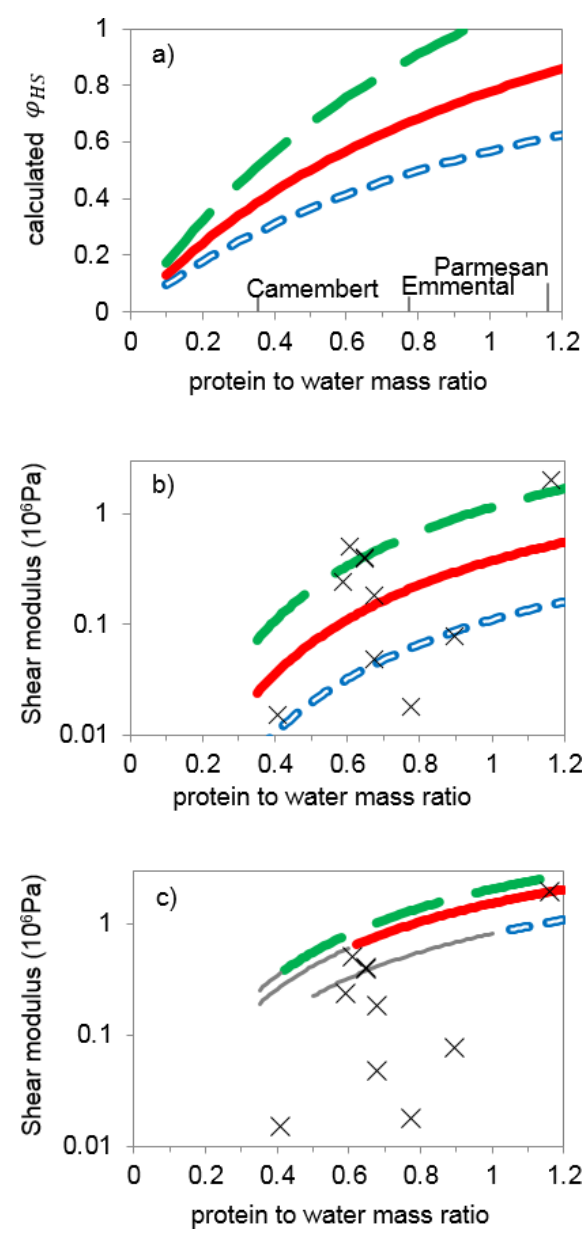
Figure 4: Calculations derived from protein to water mass ratio. 4a) Hard sphere volume fraction. 4b) Calculated shear modulus of the protein matrix calculated assuming G ′ ∼ Aφ HSb where A = 10 6 Pa and b = 3.5. 4c) shear modulus of the protein matrix calcu- lated from Evans and Lips [46]. Crosses indicate initial (low strain) compression modulus of cheeses obtained from reference [41] and references within; where data sample multiple ages were given, the data from the youngest sample was used. Lines indicate calcula- tions using different hard sphere radii: dashed green line 5.5nm, solid red line 5.0nm, hollow blue rectangles 4.5nm. Figure 4c) grey lines show the extrapolated calculation below the glass transition to demonstrate curvature but have no